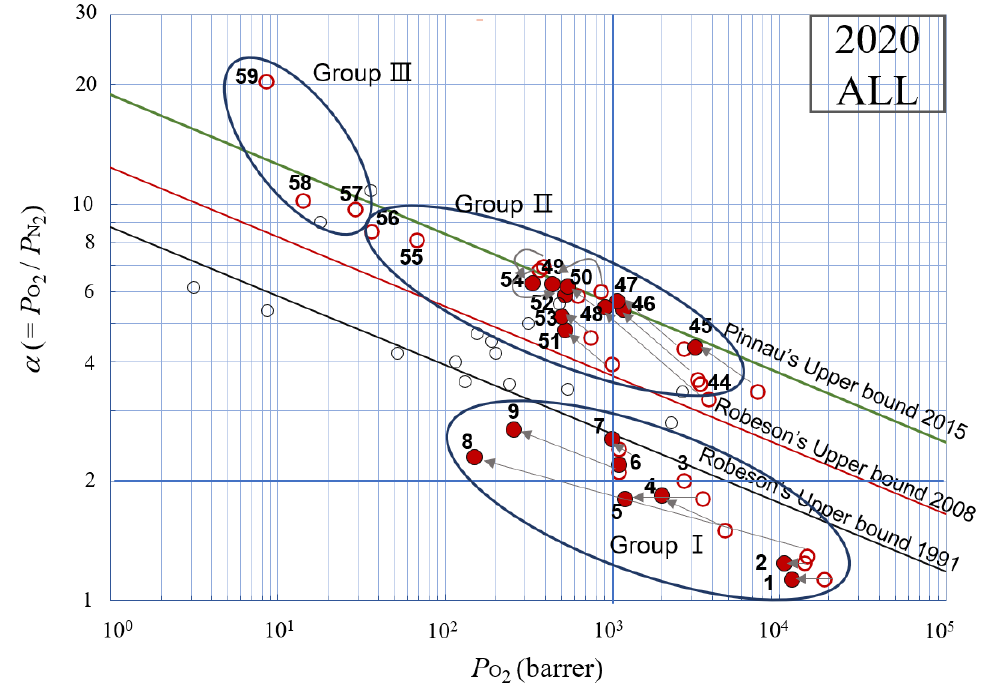
reported in the literature 2